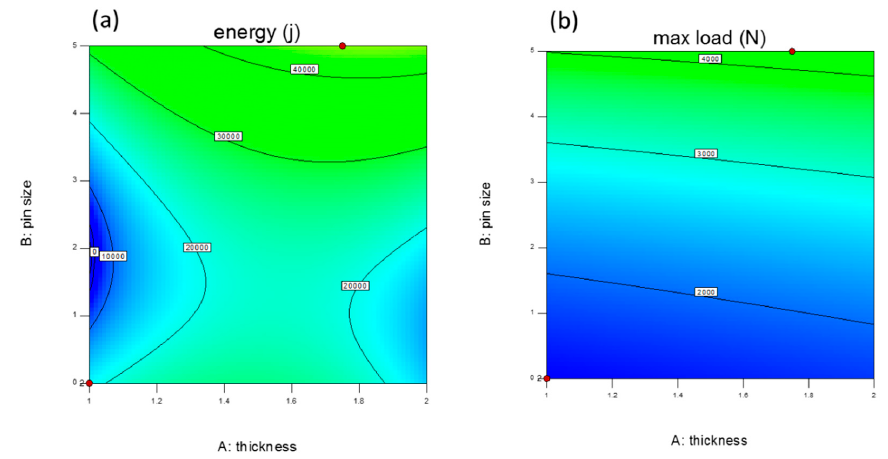
Figure 15. Response prediction plot for ( a ) Energy absorption and ( b ) maximum peak load.